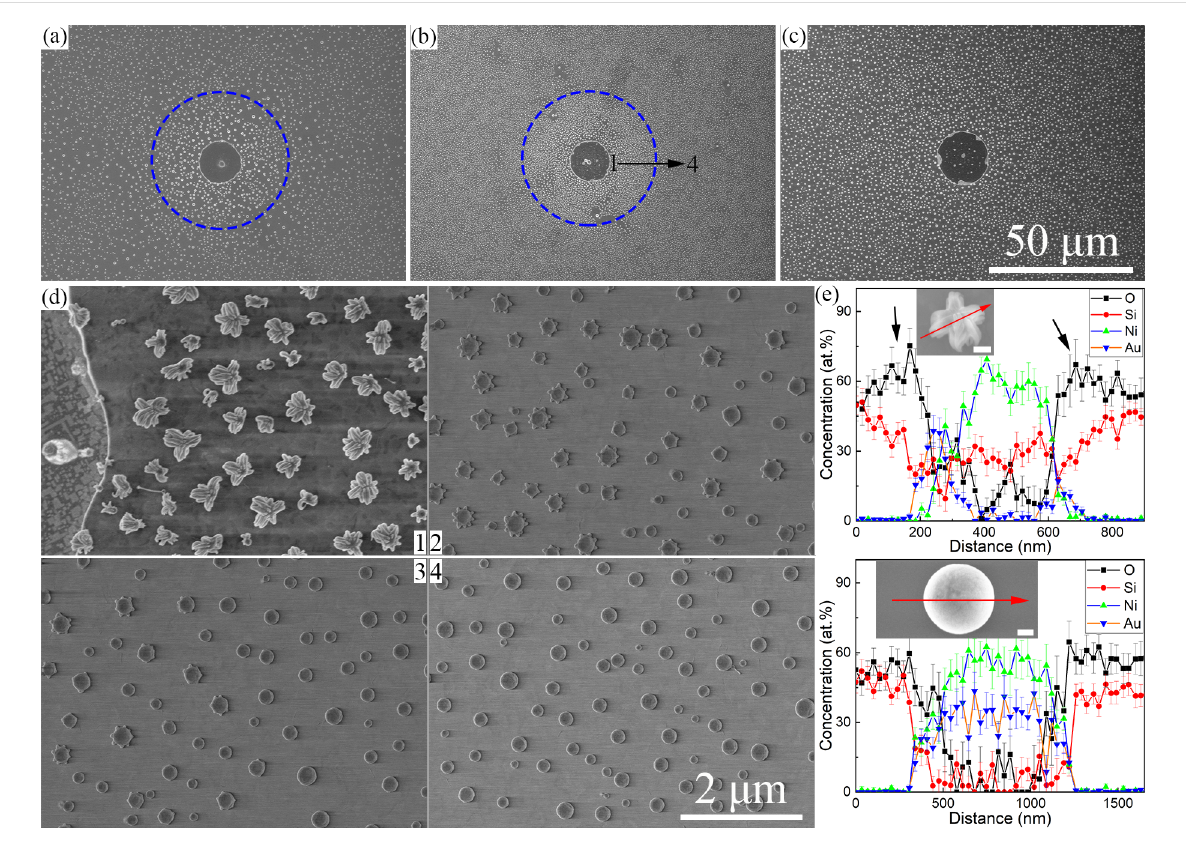
Figure 1: Morphology around decomposed areas (a–c). Distribution and composition of nanoflowers and particles outside the decomposition cavity in 10Au10Ni, respectively (d, e). Images (a–c) show 5Au15Ni, 10Au10Ni and 15Au5Ni, respectively. The dotted circles in (a, b) show the boundary of nanoflowers and particles. Images 1–4 in (d) show areas increasingly further away from the border of the cavity in 10Au10Ni, as marked in (b). The scale bar in (c) is also valid for (a, b), and the scales of the four images in (d) are the same. The scale bars of the inset in (e) are 200 nm.